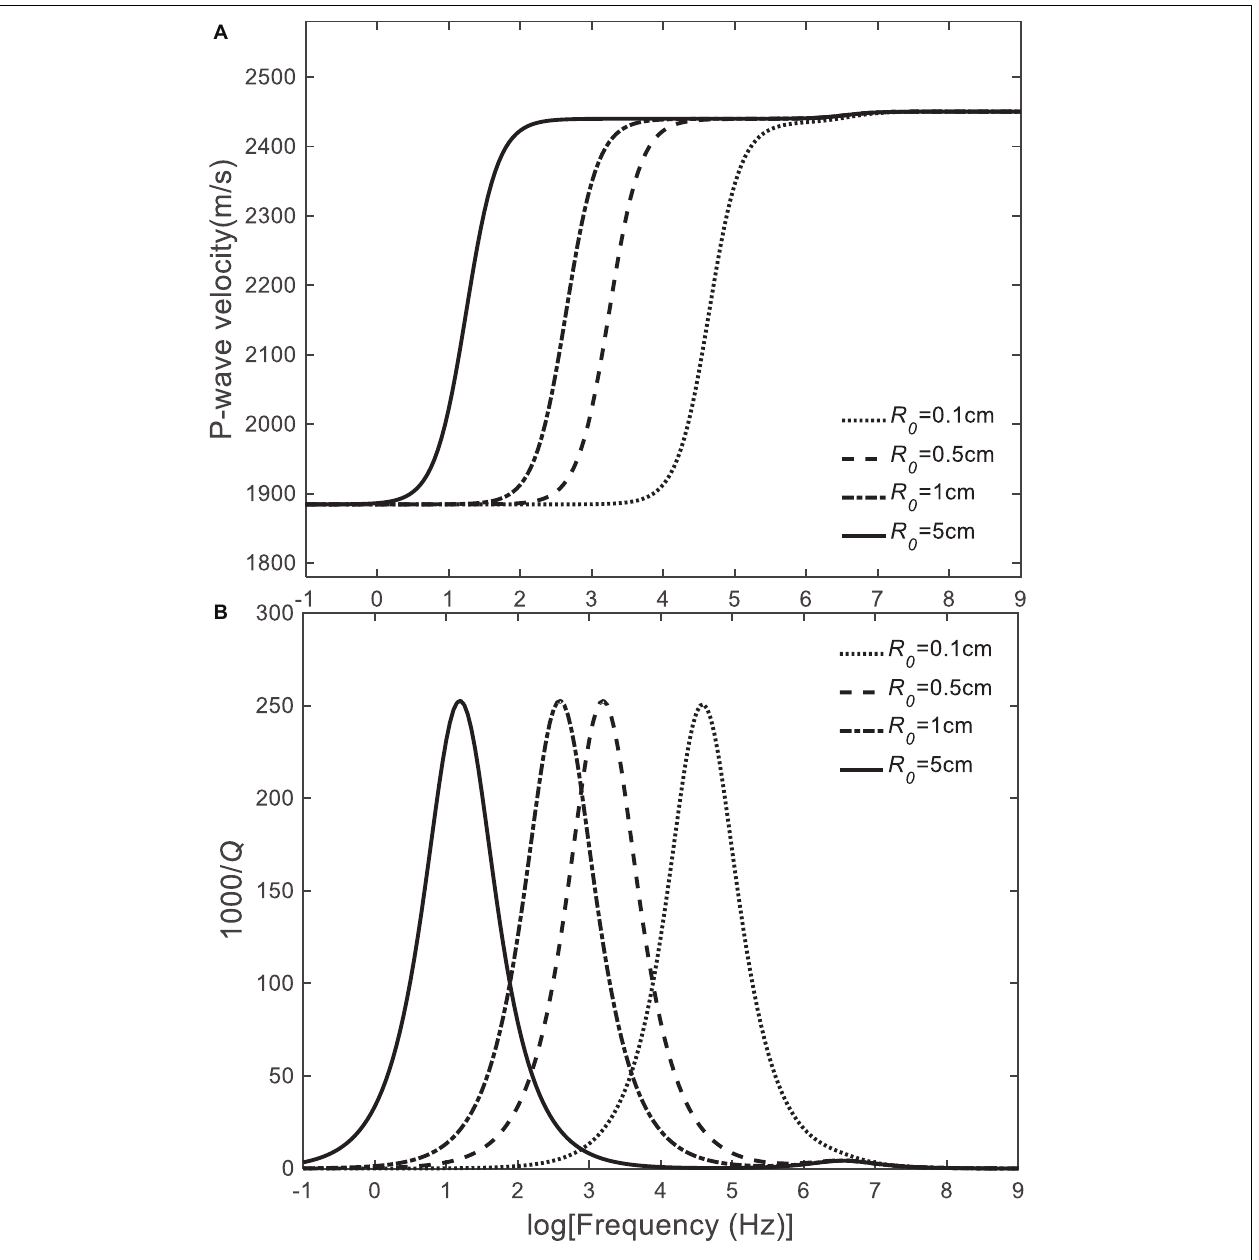
FIGURE 8 | Model 2. P-wave velocity (A) and dissipation factor (B) as a function of frequency for different inclusion radii of hydrate/gas. The hydrate concentration is 20% and the porosity is 40%.